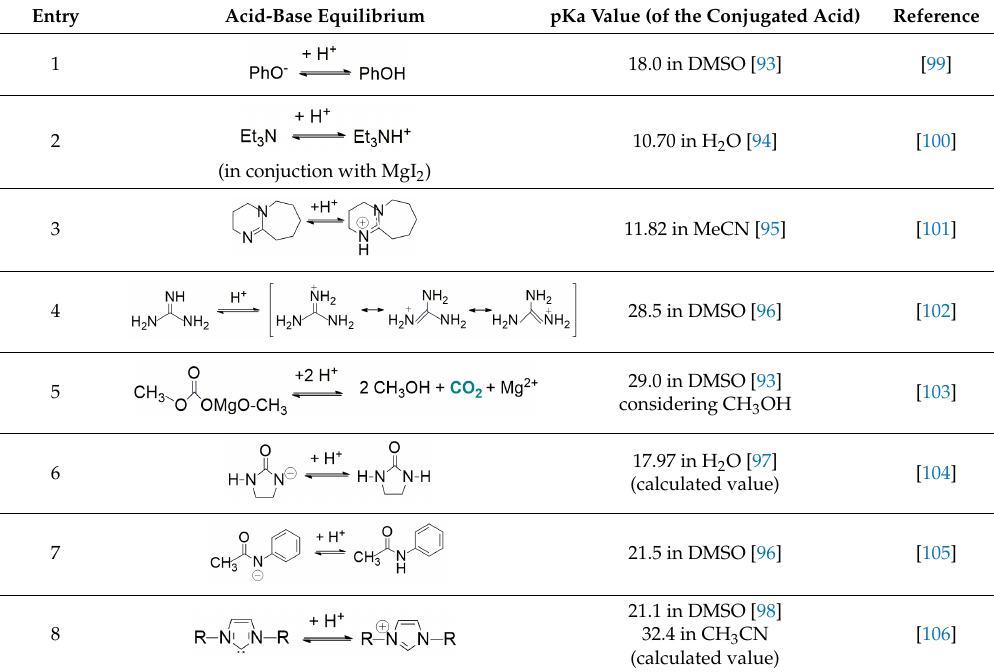
Table 1. Organic bases frequently used in Brønsted ‐ base ‐ promoted carboxylation of active hydrogen compounds with CO 2 .